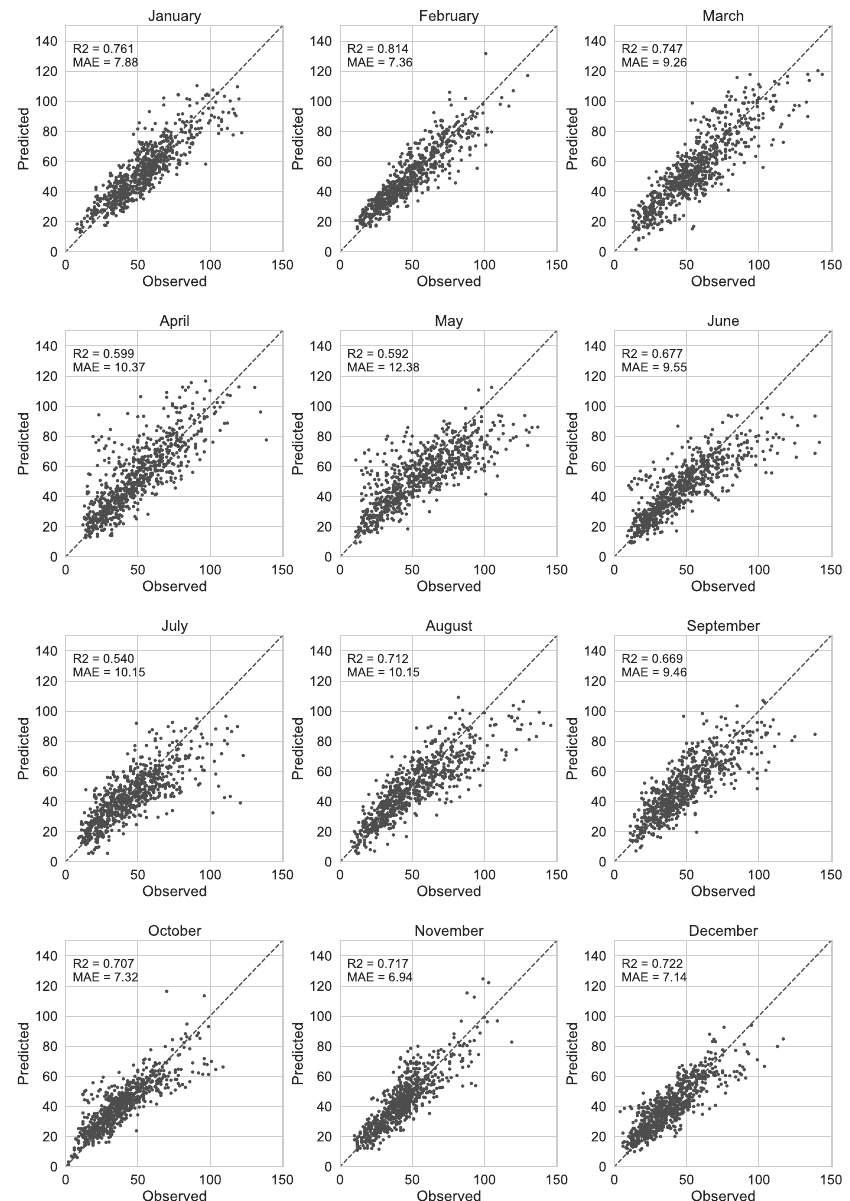
Figure 3. Observed vs. predicted NO 2 concentrations ( µ g/m 3 ) in each month of